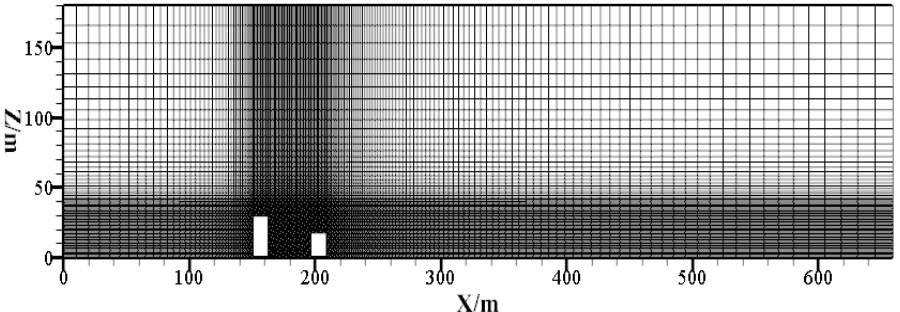
Figure 3. Schematic diagram of grid demarcation in a cross-section.